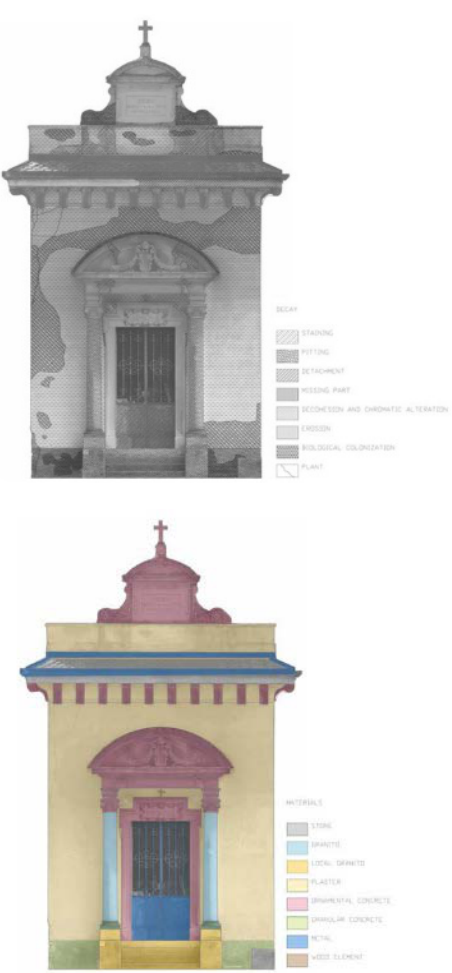
Figure 9: Material and decay mapping of the main façade of Chapel three (architectural